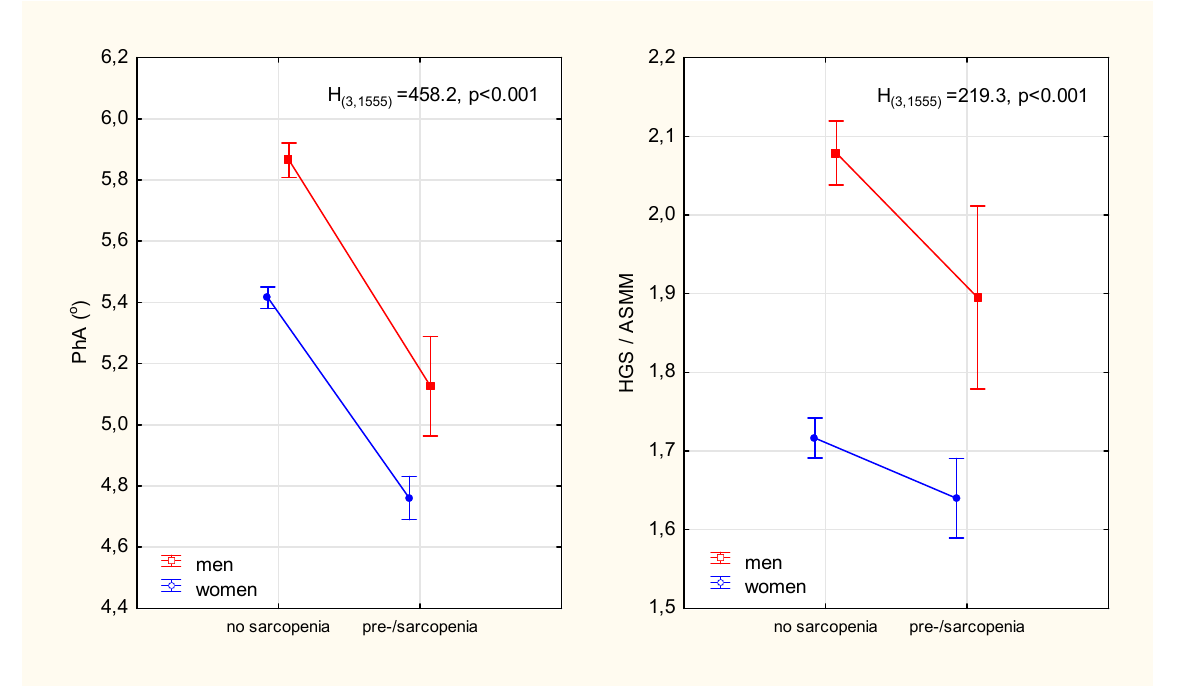
Figure 2. Differences in the phase angle of impedance and the index of the functional quality of the appendicular skeletal muscles between participants diagnosed with pre-sarcopenia and participants without sarcopenia. Points with vertical lines represent the mean with 95% confidence intervals; PhA—phase angle; HGS—hand grip strength; ASMM—appendicular skeletal muscle mass; H (3,1555) , p-Kruskal-Wallis rank ANOVA test results. Table 2. Logistic regression models for the likelihood of pre-sarcopenia in adults after 50 years of age. Predictor